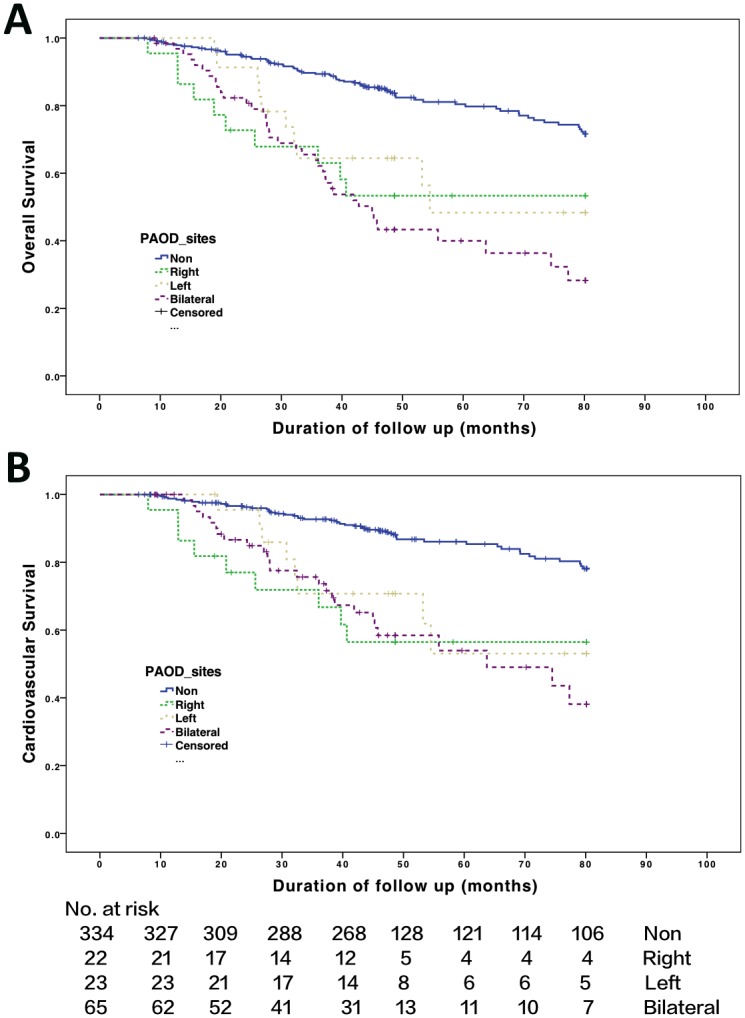
Kaplan—Meier survival curves.Probabilities of (A) overall survival with log-rank test: χ2 = 60.89; P ≤ 0.001 in the four groups and χ2 = 2.02; P = 0.364 in the three PAOD groups. (B) Cardiovascular survival with log-rank test: χ2 = 45.24; P ≤ 0.001 in the four groups and χ2 = 0.69; P = 0.708 in the three PAOD groups.